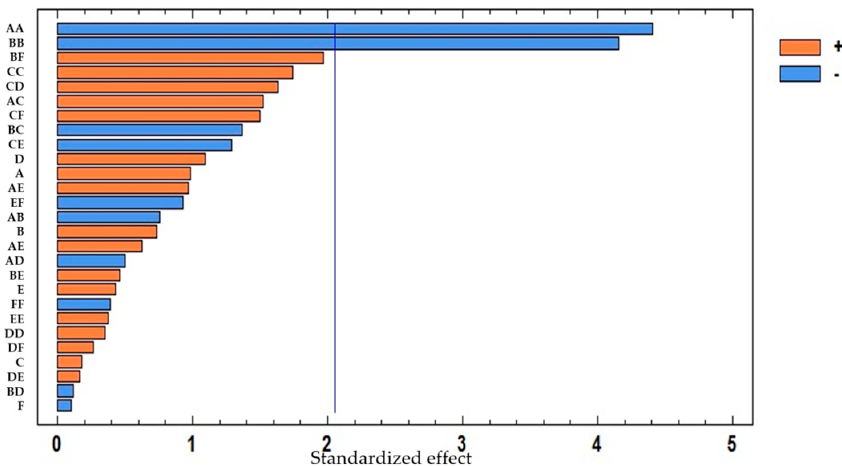
Figure 3. Standardized Pareto chart for TPC extraction. A: Solvent (% MeOH); B: Temperature (°C); C: Amplitude (%); D: Cycle (s); E: pH; F: Ratio (mL).